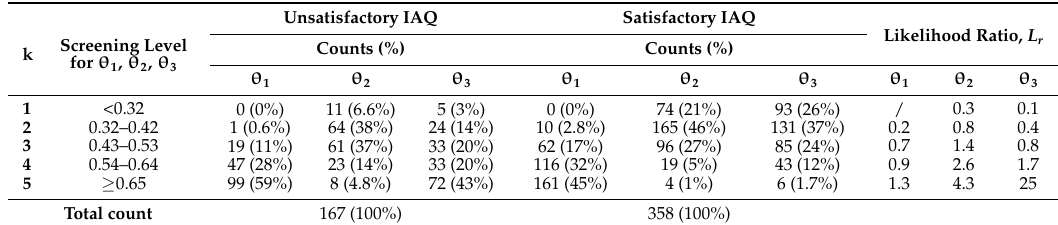
Table 2. IAQ indices and likelihood ratios for unsatisfactory IAQ in air-conditioned Hong Kong offices. Unsatisfactory k Screening Level for θ 1 , θ 2 , θ 3